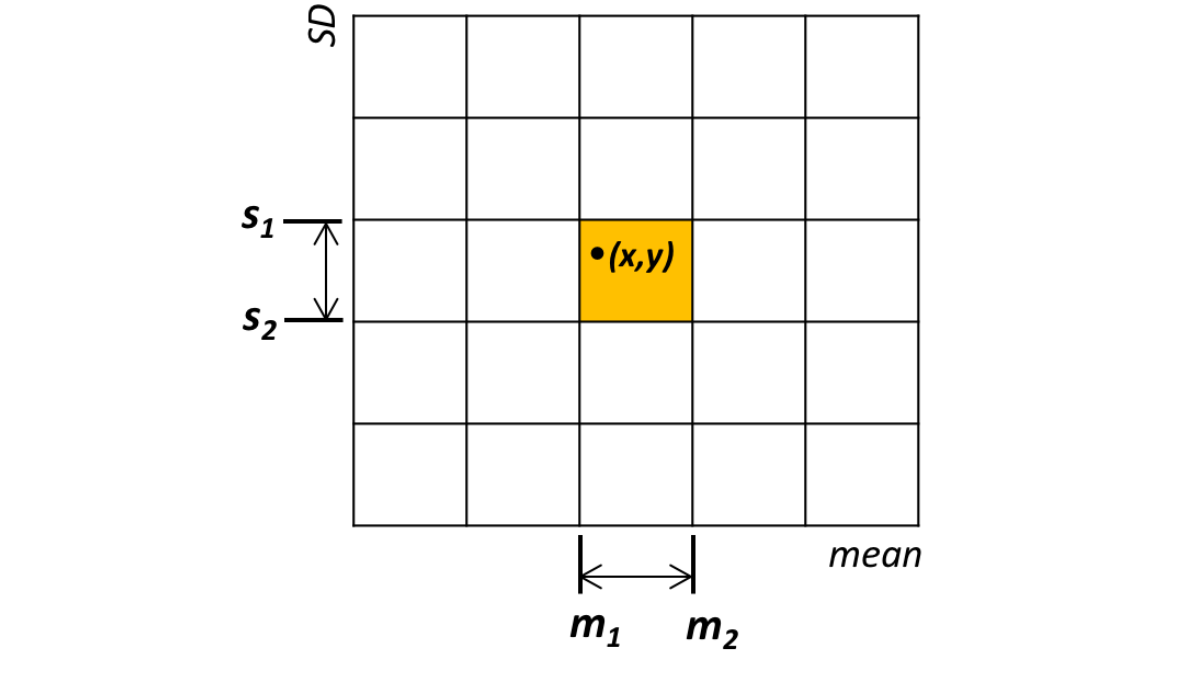
Figure 4. Scatter plot of the mean, SD, and duration of the